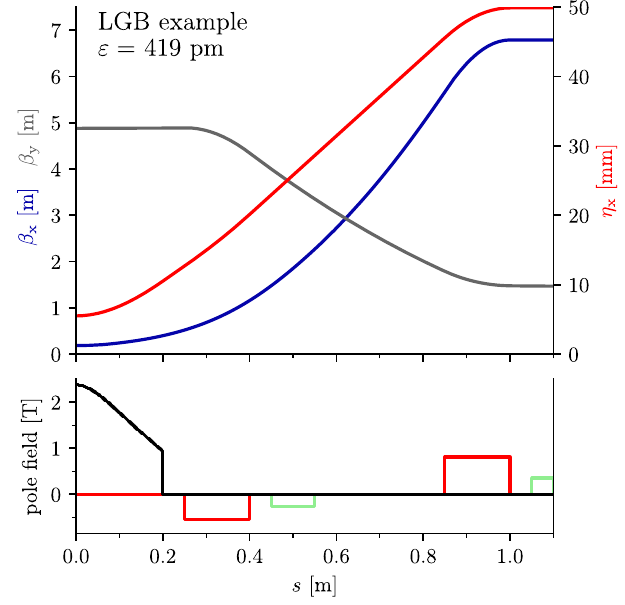
FIG. 8. Example half cell with optimization of longitudinal field variation ( b ≥ 0 ) in its bend (see Fig. 4 for legend.)